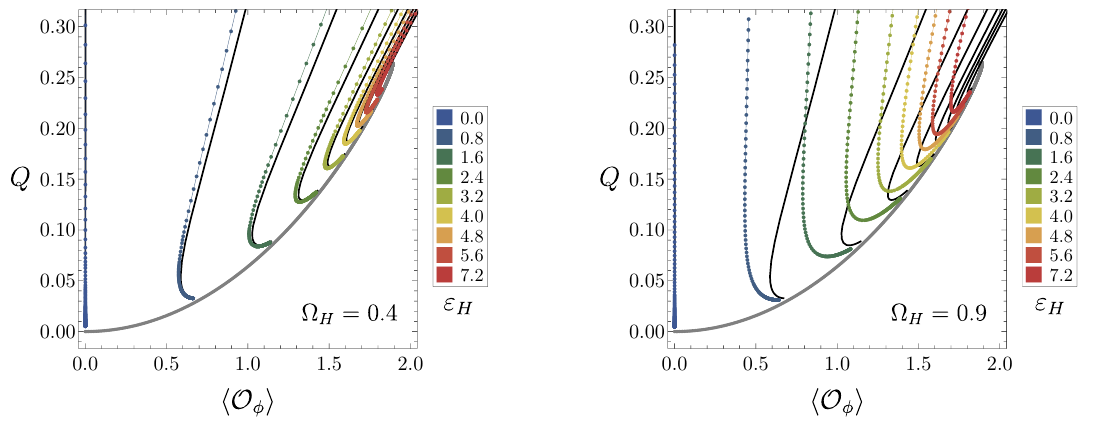
Figure 13 . Black hole charge Q against the vacuum expectation value hO (cid:30) i of the operator dual to the scalar (cid:12)eld (cid:30) , at (cid:12)xed horizon scalar charge " H , and (cid:12)xed horizon angular velocity (cid:10) H = 0 : 4 ( left ), and (cid:10) H = 0 : 9 ( right ), in the non-rotating frame at in(cid:12)nity. In black are the corresponding val- ues for the non-rotating solutions (cid:10) H = 0, J = 0. The smooth BPS soliton family is shown in